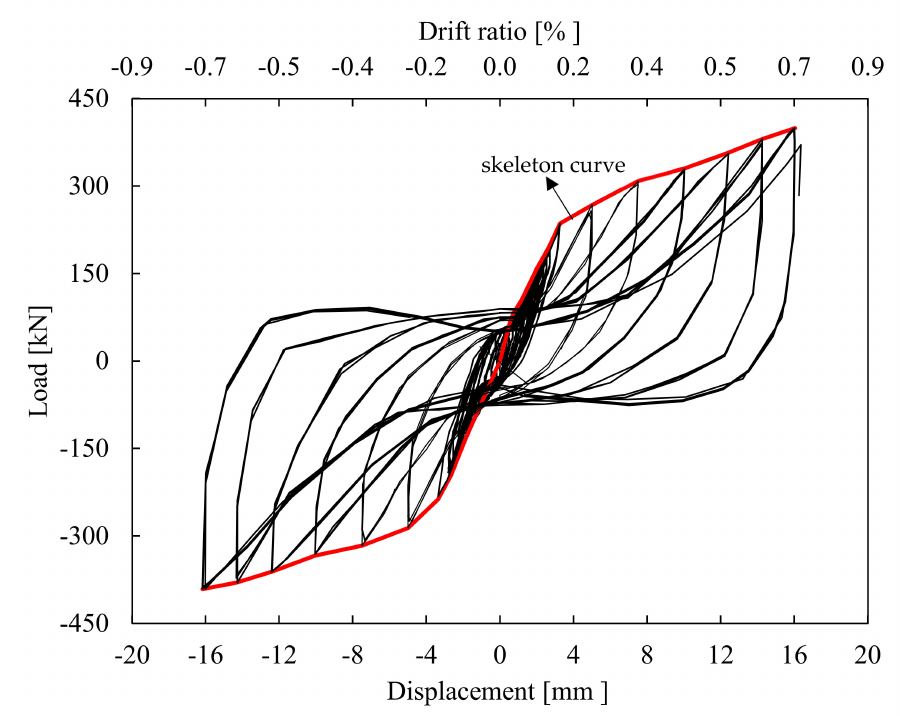
Figure 24. Load versus displacement curve of the tested PCSP-ISF